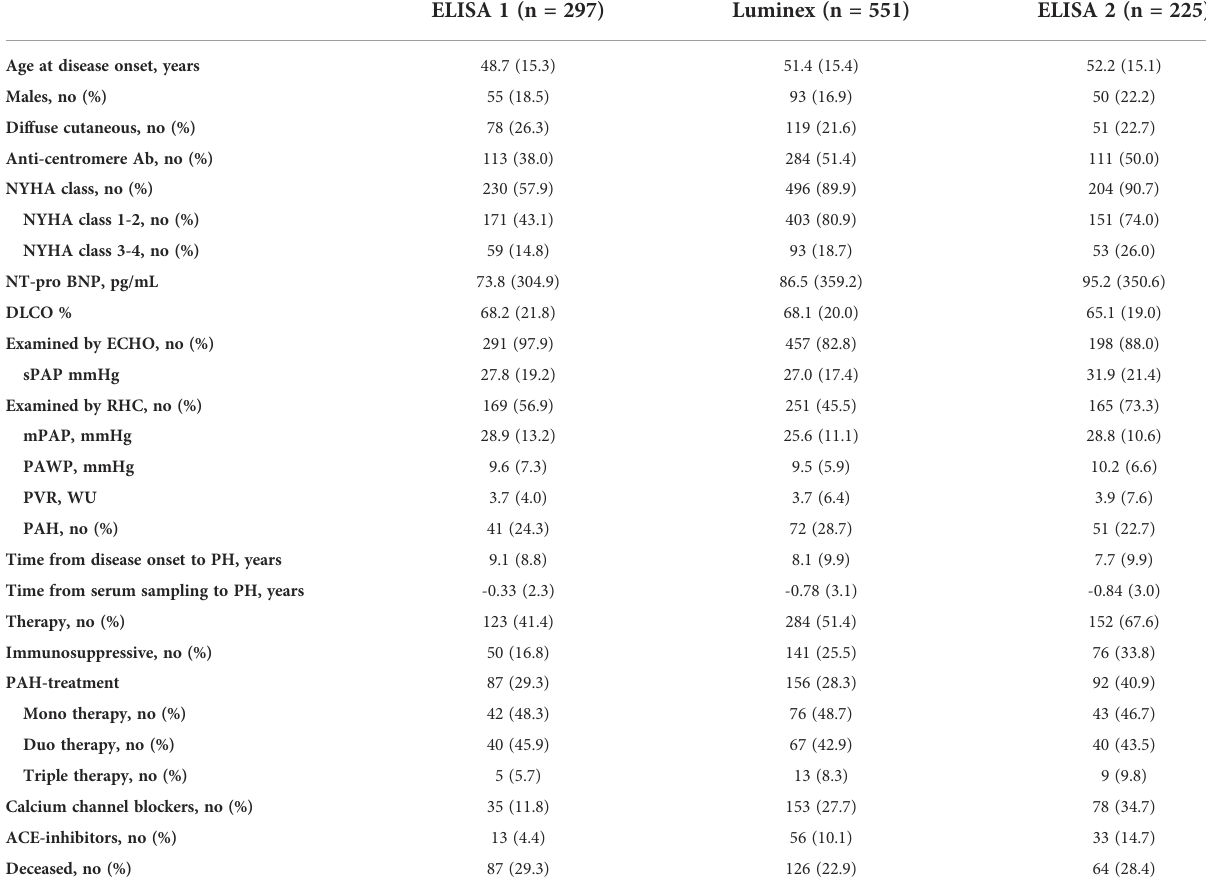
TABLE 2 Key demographic and clinical data of SSc patients in the ELISA 1, Luminex and the ELISA